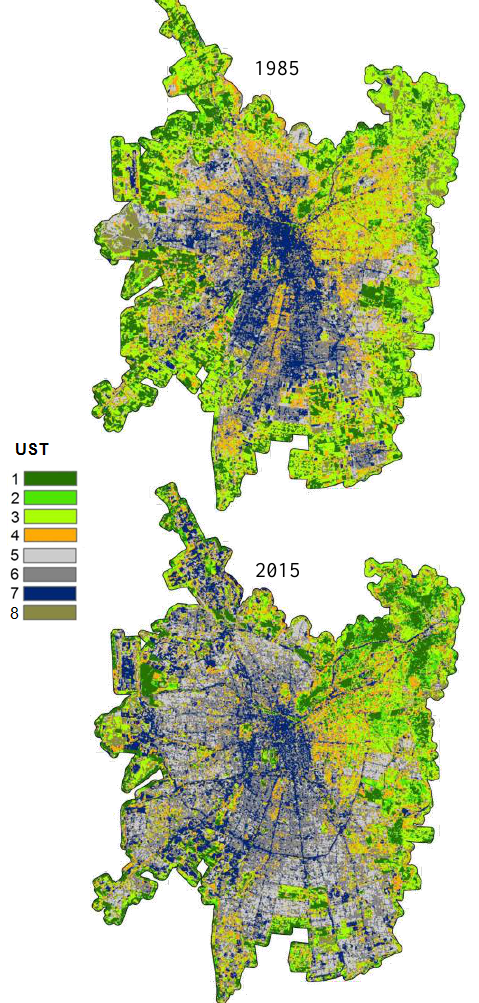
Figure 3. Urban Structural Units of Santiago in 1985 and 2015. USTs are described in Table 1. UST 8 corresponds to unclassified pixels.